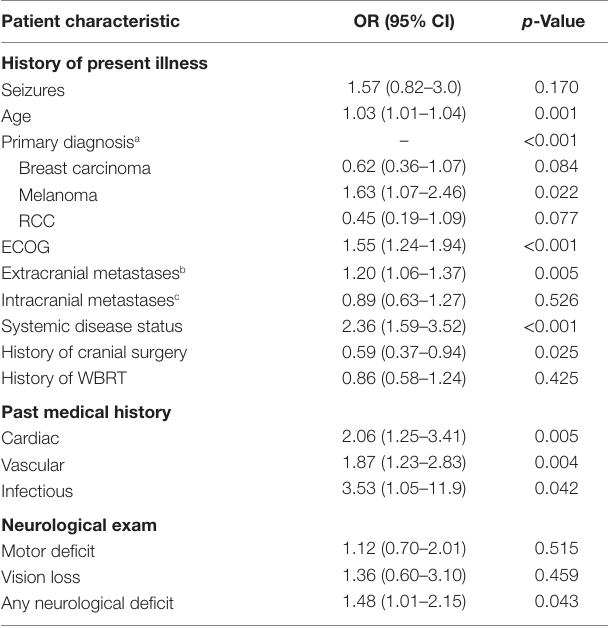
TaBle 3 | Predictors of overall survival from hPi, PMh, and neurological exam on univariate analysis.